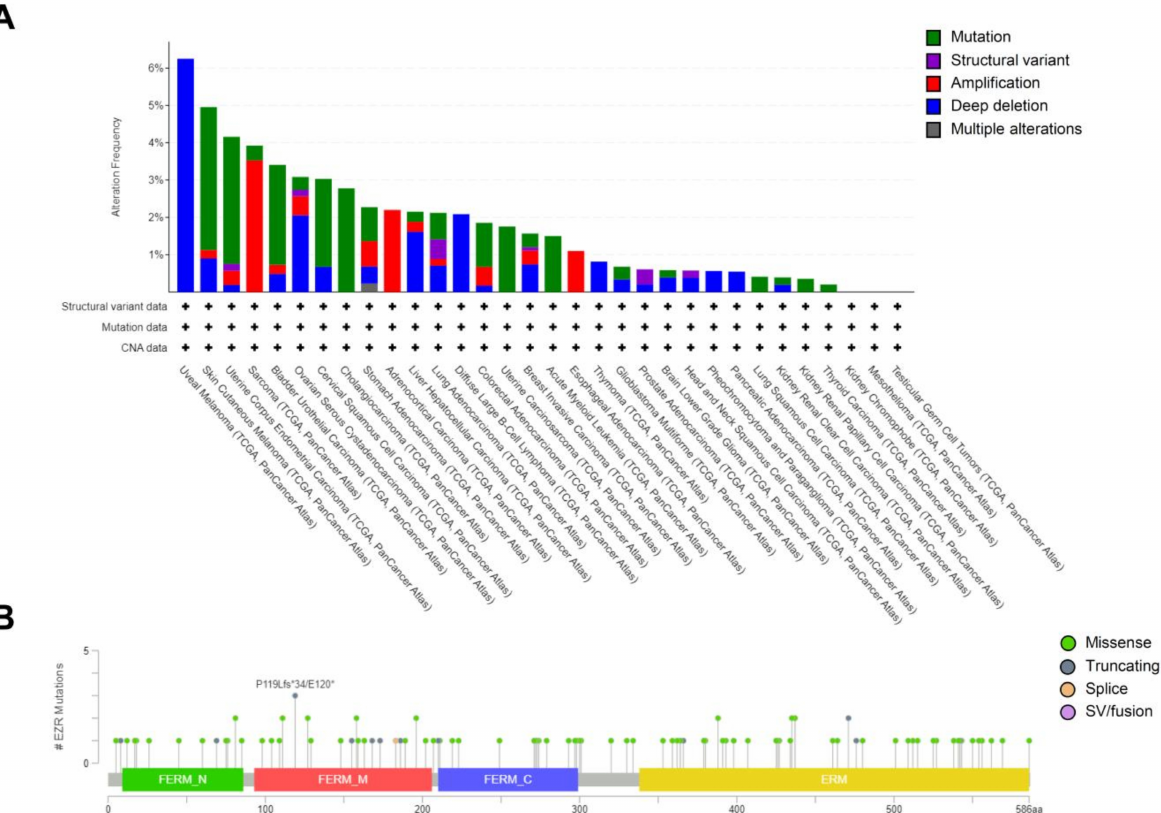
Figure 3. EZR genomic alterations in cancer. ( A ) Distribution of EZR genetic alterations in The Cancer Genome Atlas (TCGA) cohorts (10953 patients in 32 studies). ( B ) A total of 110 somatic mutations were found: 84 missense substitutions, 16 truncating, one splice mutation, and nine gene fusions. The figures were obtained using the cBioPortal (http://www.cbioportal.org, accessed on 2 August